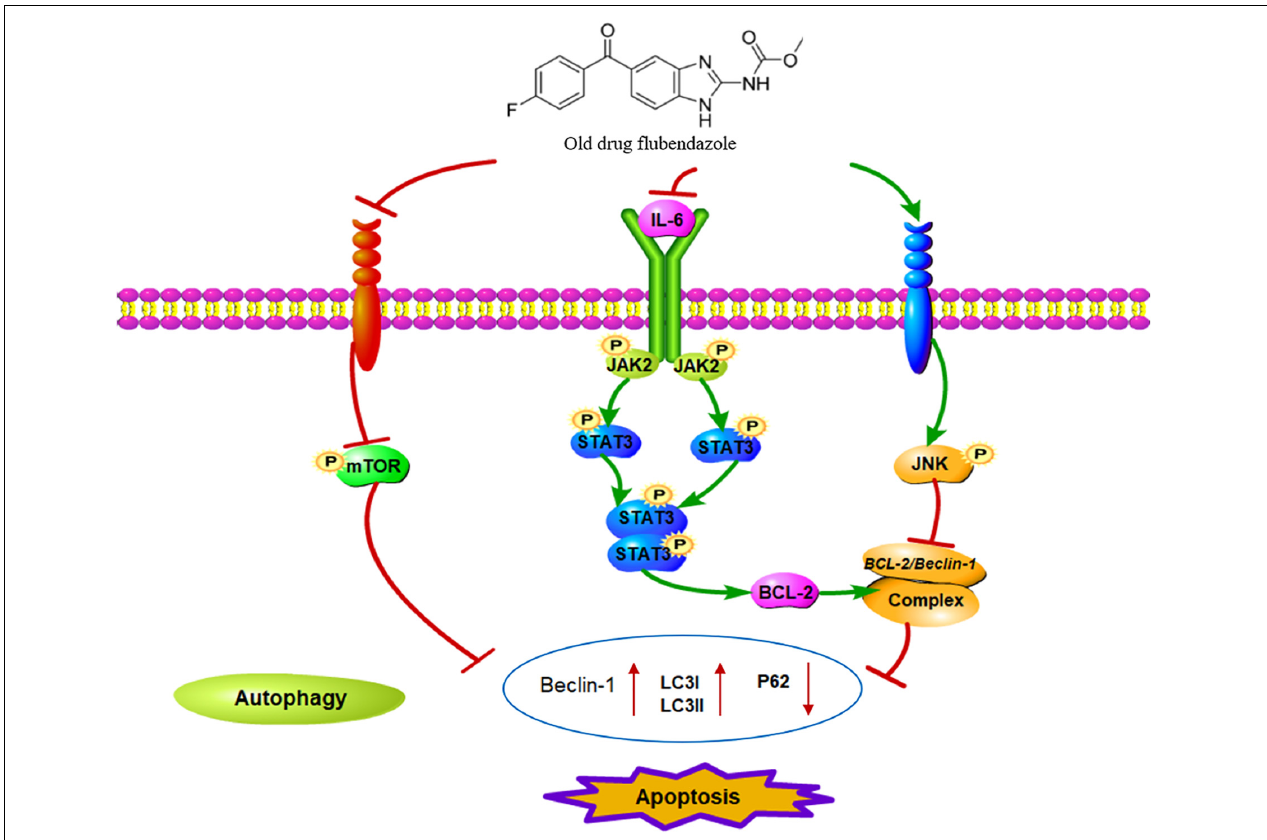
FIGURE 7 | Schematic diagram of the potential antitumor mechanism of flubendazole via inhibition of STAT3 and activation of autophagy in cancer